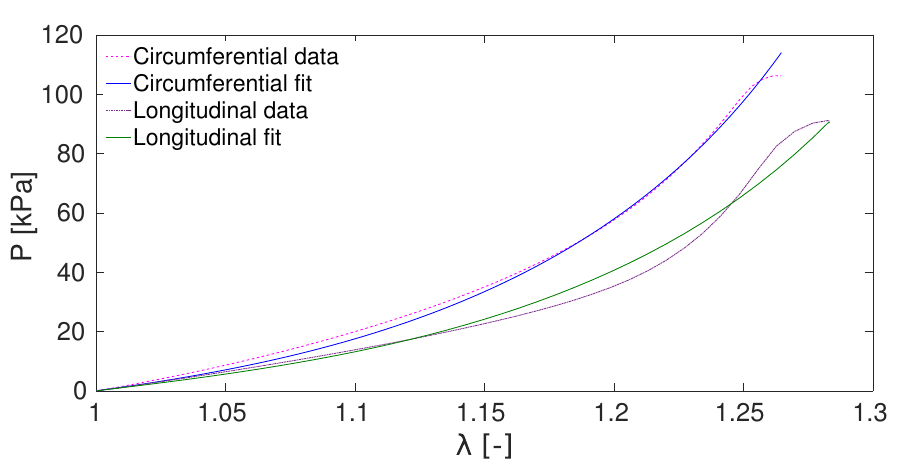
Figure 3. Experimental data of uniaxial tension tests and computational fitting obtained with the proposed constitutive law.